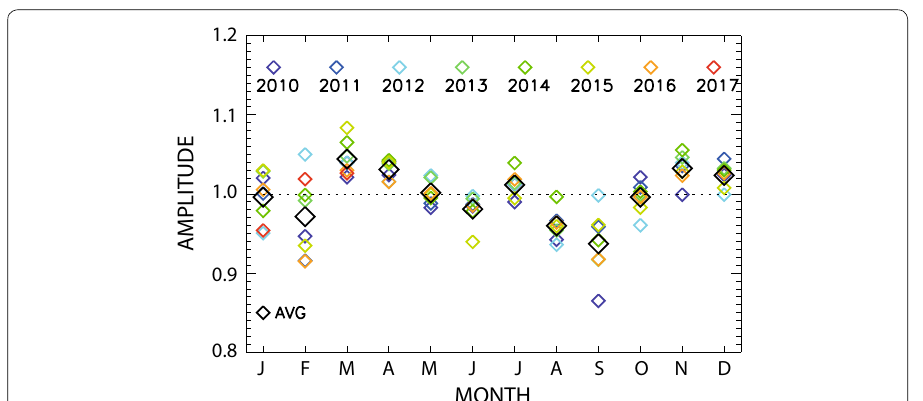
Fig. 6 The monthly averaged amplitude of the normalized PC time series of the weekly cycle during the data period. The black diamonds represent the averages of the monthly averaged